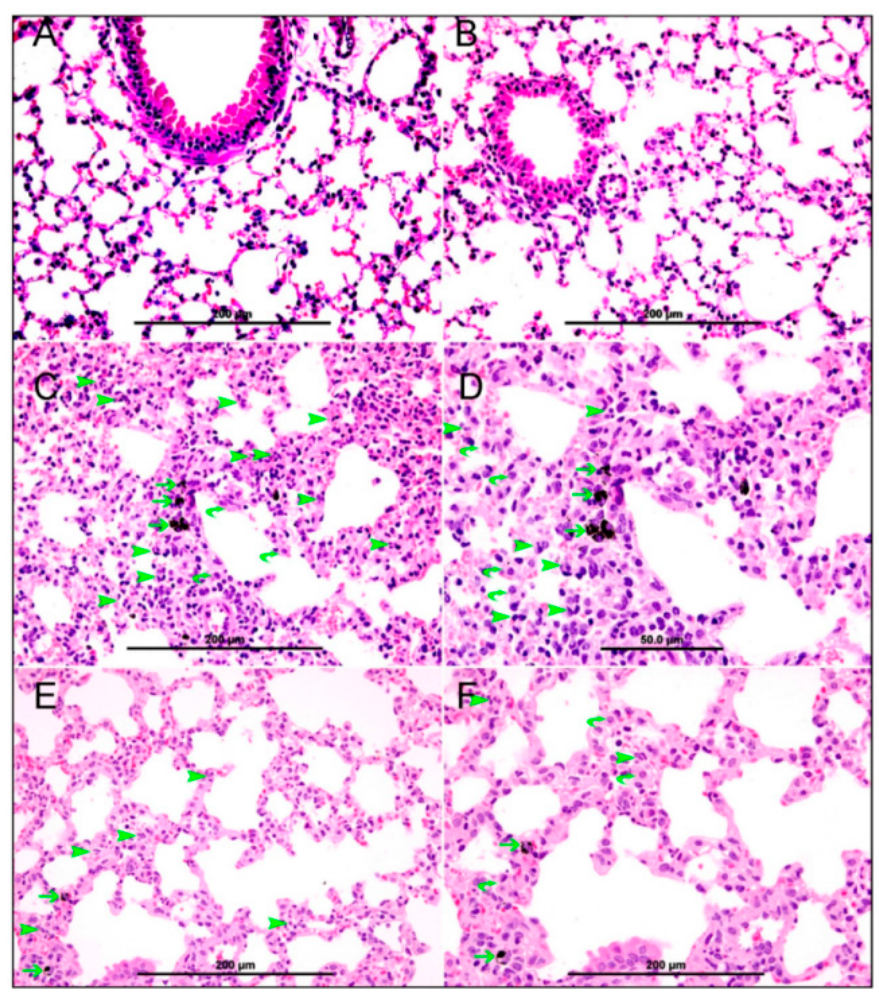
Figure 2. Representative light microscopy sections of lung tissues of mice, 24 h after administration of saline ( A ), nootkatone (NK)+saline ( B ), diesel exhaust particles (DEP; 30 µg/animal; C , D ), and NK+DEP ( E , F ). ( A , B ) Both saline and NK+saline groups show normal lung tissue with unremarkable changes. ( C , D ) DEP-exposed lungs show particles within alveolar macrophages (thin arrows). There is severe expansion of the alveolar interstitial space with many neutrophil polymorphs (arrow head), and many macrophages (curved arrow). ( E , F ) The NK+DEP group shows DEP particles within alveolar macrophages (thin arrows). There is mild expansion of the alveolar interstitial space with a few neutrophil polymorphs (arrow head), and a few macrophages (curved arrow).